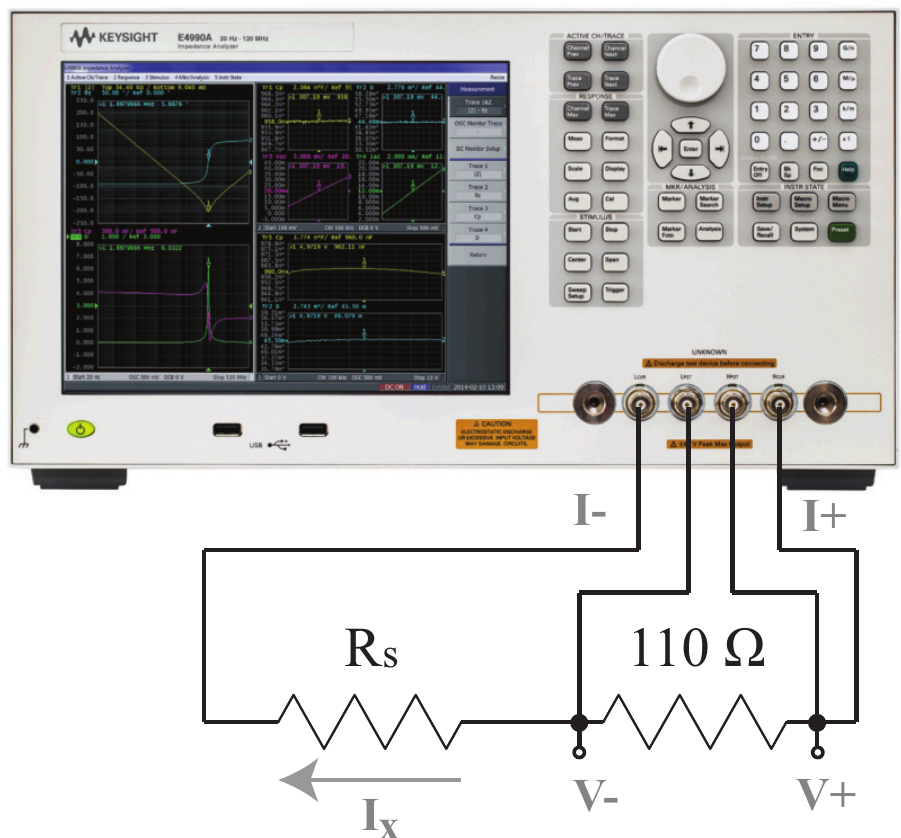
Figure A1. Test setup for limiting the Keysight E4990A excitation current with a series residual resistor ( R s ) during the measurement of a 110 Ω